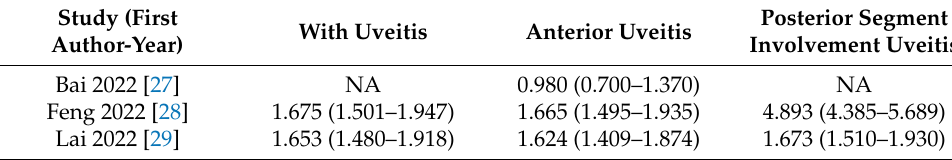
Table 2. Types of uveitis and adjusted HRs on atherosclerosis-related CVD included in the study.